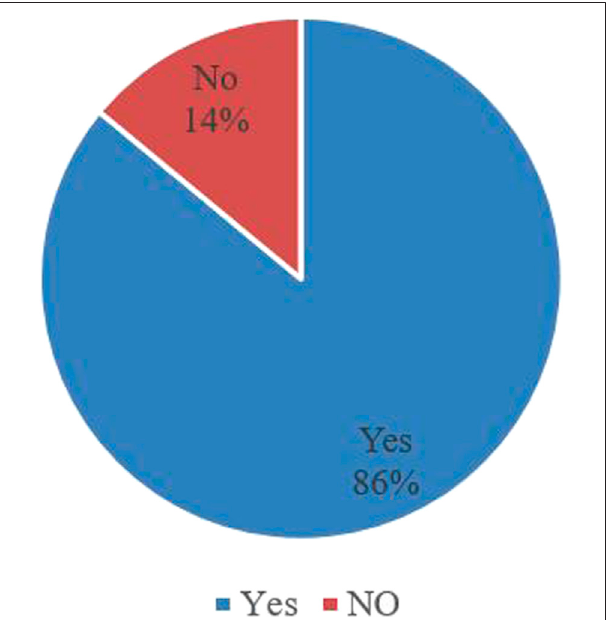
FIGURE 4 | Familiarity of respondents with car sharing.